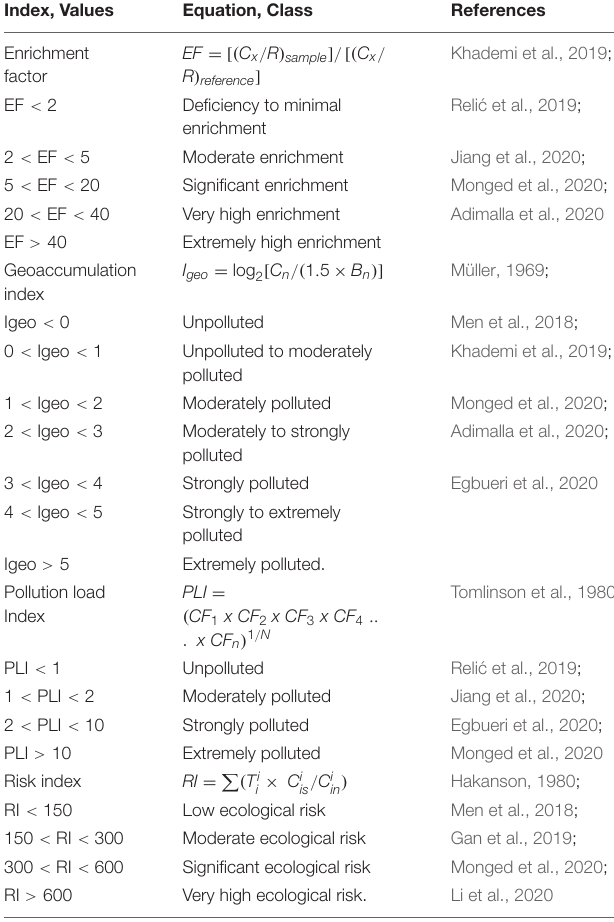
TABLE 1 | Criteria for soil classification using pollution